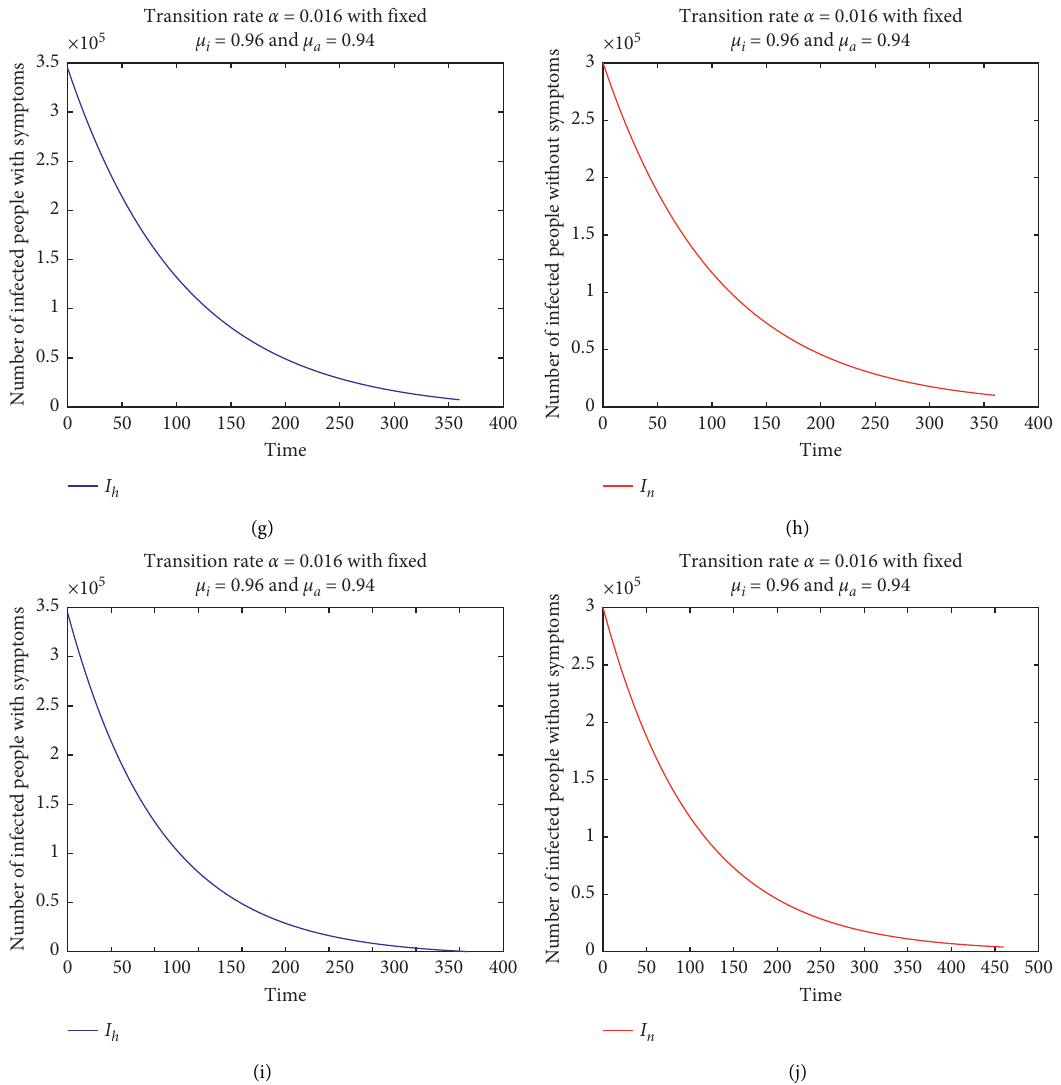
Figure 12 : Prediction of infection cases in Saudi Arabia based on SEIR model with an infection rate α = 0.015 of symptomatic type for (a) 360 days, (c) 400 days, and (e) 460 days and of asymptomatic type for (b) 360 days, (d) 400 days, and (f) 460 days and with an infection rate α = 0.016 of symptomatic type for (g) 360 days and (i) 460 days and of asymptomatic type for (h) 360 days and (j) 460